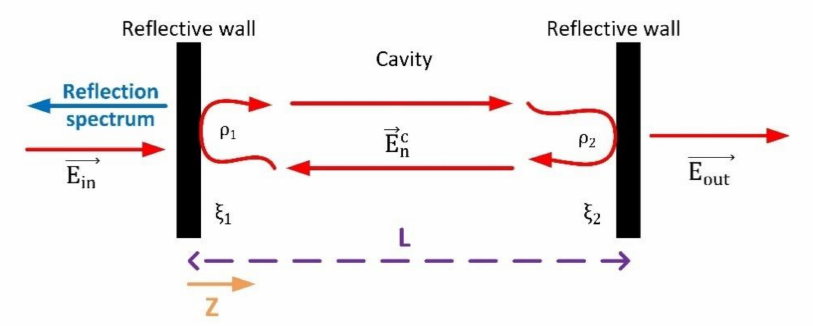
Figure 3. Resonant cavity-like